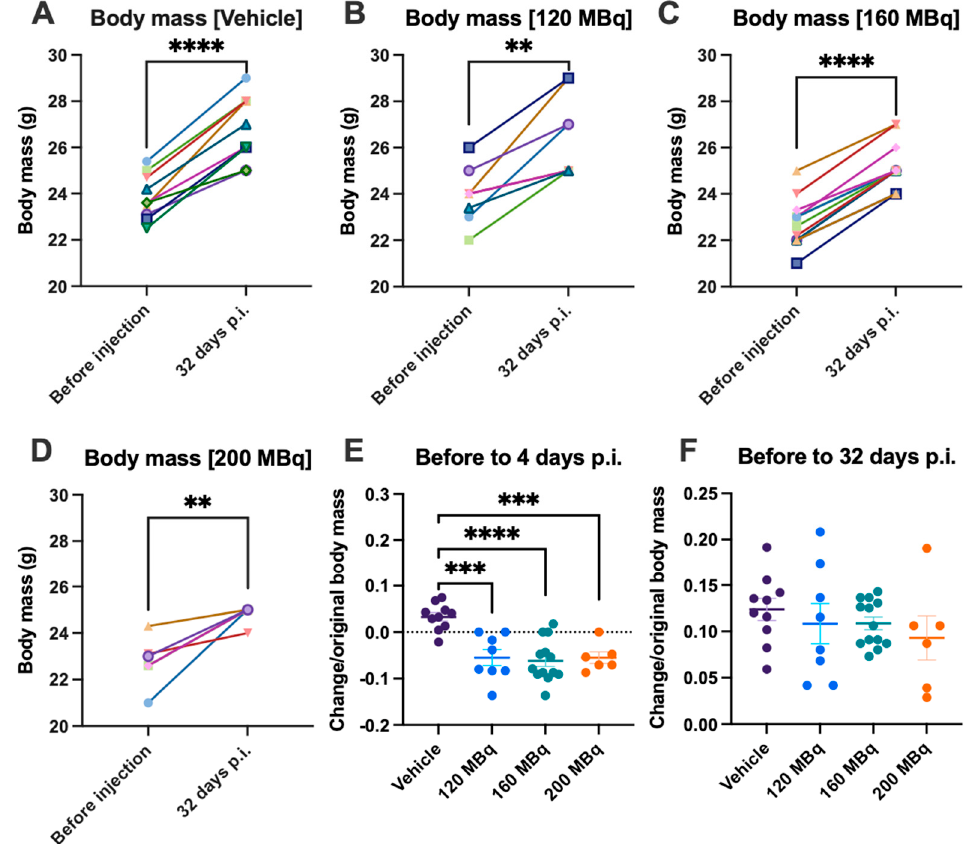
Figure 6. Body mass gain from before injections until 32 days post injections for ( A ) vehicle, ( B ) 120 MBq, ( C ) 160 MBq, and ( D ) 200 MBq. The increase or decrease in body mass presented as a fraction of original body mass with group mean ± SEM after 4 days ( E ) and 32 days post injections ( F ). Differences between before and after ( A – D ) were analyzed with a paired t -test, and differences between groups ( E , F ) were analyzed using one-way ANOVA with post-hoc Tukey. ** p < 0.01, *** p < 0.001, **** p < 0.0001.